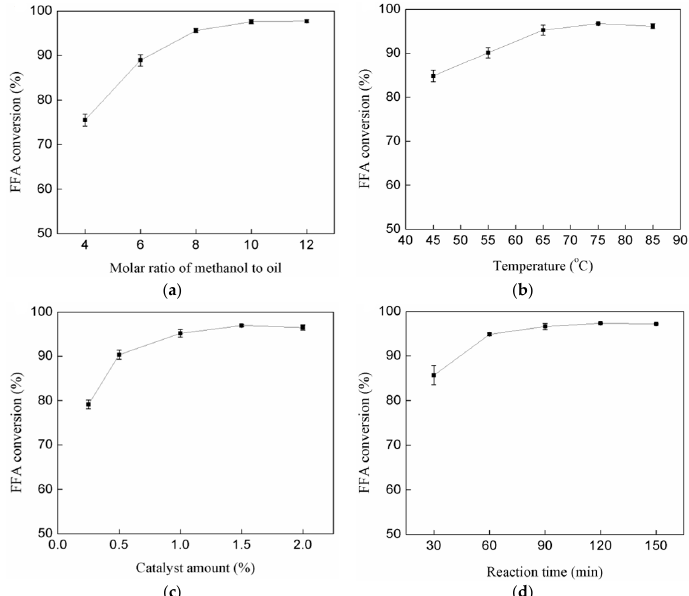
Figure 1. Effects of ( a ) molar ratio of methanol to oil (with a fixed temperature of 75 °C, 1% H 2 SO 4 , and a reaction time of 60 min); ( b ) temperature (with a fixed methanol:oil molar ratio of 10:1, 1% H 2 SO 4 , and a reaction time of 60 min); ( c ) catalyst amount (with a fixed methanol:oil molar ratio of 10:1, a temperature of 65 °C, and a reaction time of 60 min); and ( d ) reaction time (with a fixed methanol:oil molar ratio of 10:1, a temperature of 65 °C, and 1% H 2 SO 4 ) on FFA conversion in soursop seed oil.